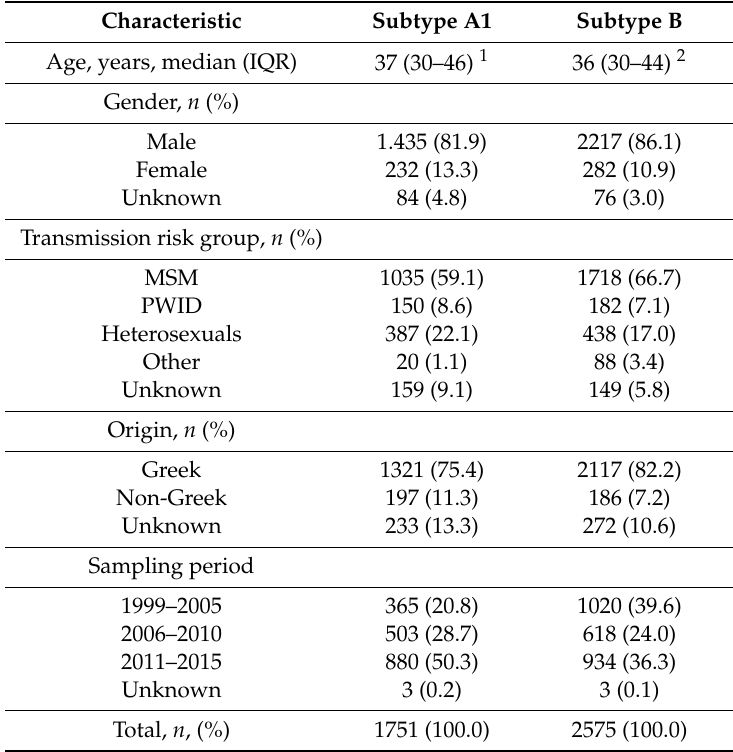
Table 1. Demographic characteristics of a subset of the study population (i.e., PLHIV infected with subtypes A1 and